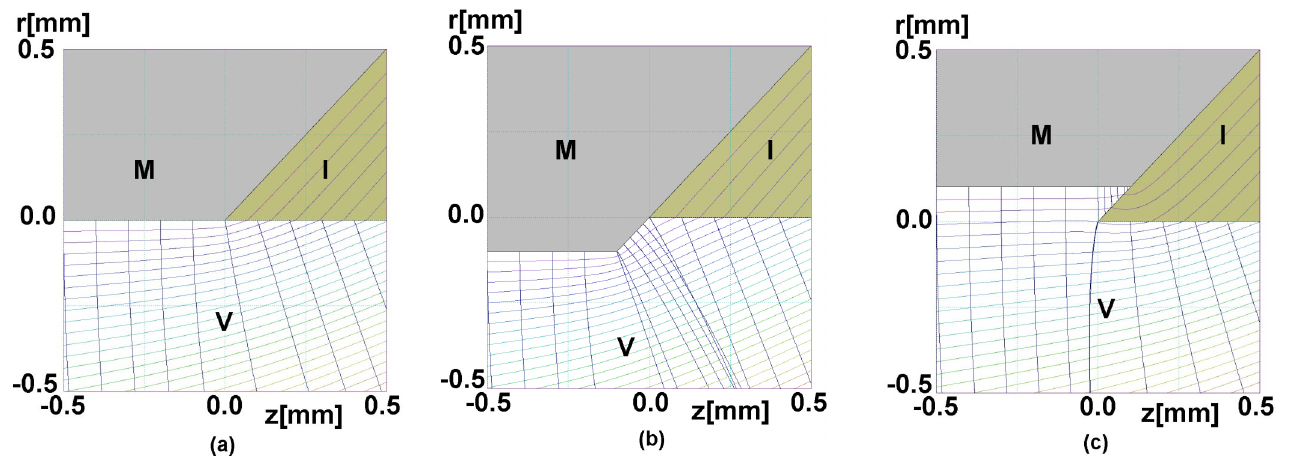
FIG. 18. (Color) Same as Fig. 17 but with the conductor-insulator interface coned to 45 (cid:4) .